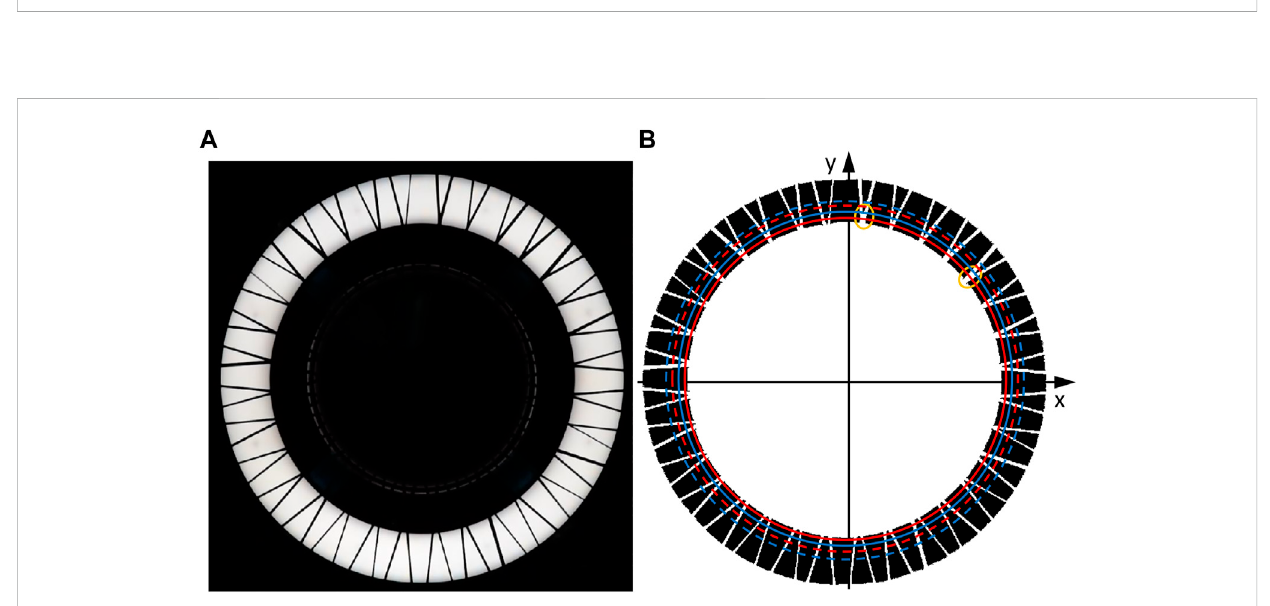
FIGURE 4 Exemplary video frame acquired by the camera that monitors the braid formation zone (A) ; identical video frame after preprocessing by the image analysis algorithm (B) ;two pairsof imaginary circles (solid and dashedcircles) drawn-in for avisualization oftheworking principle ofthemain processing of the algorithm; two orange ellipses mark areas where the circle in solid blue intersects with yarn crossing